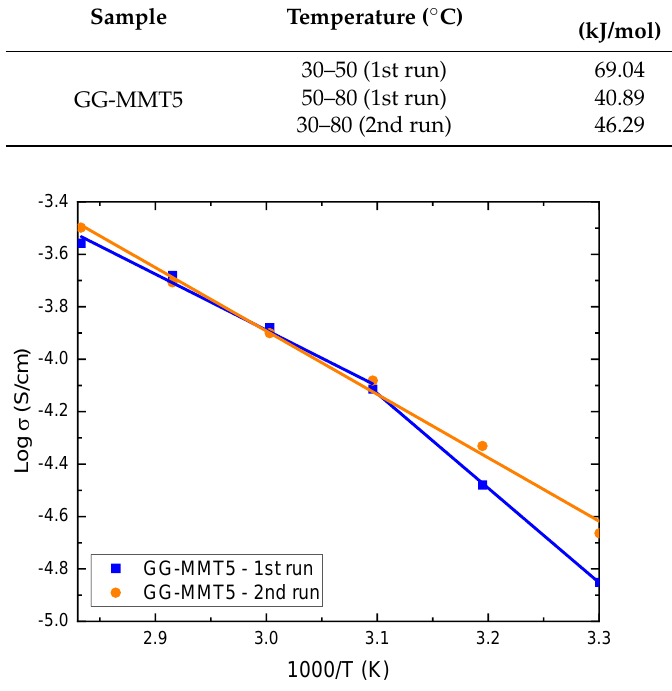
Figure 3. Log of ionic conductivity as a function of the inverse temperature of GG-MMT5 NPEs (solid symbols). The results were fitted with the Arrhenius model (solid lines).